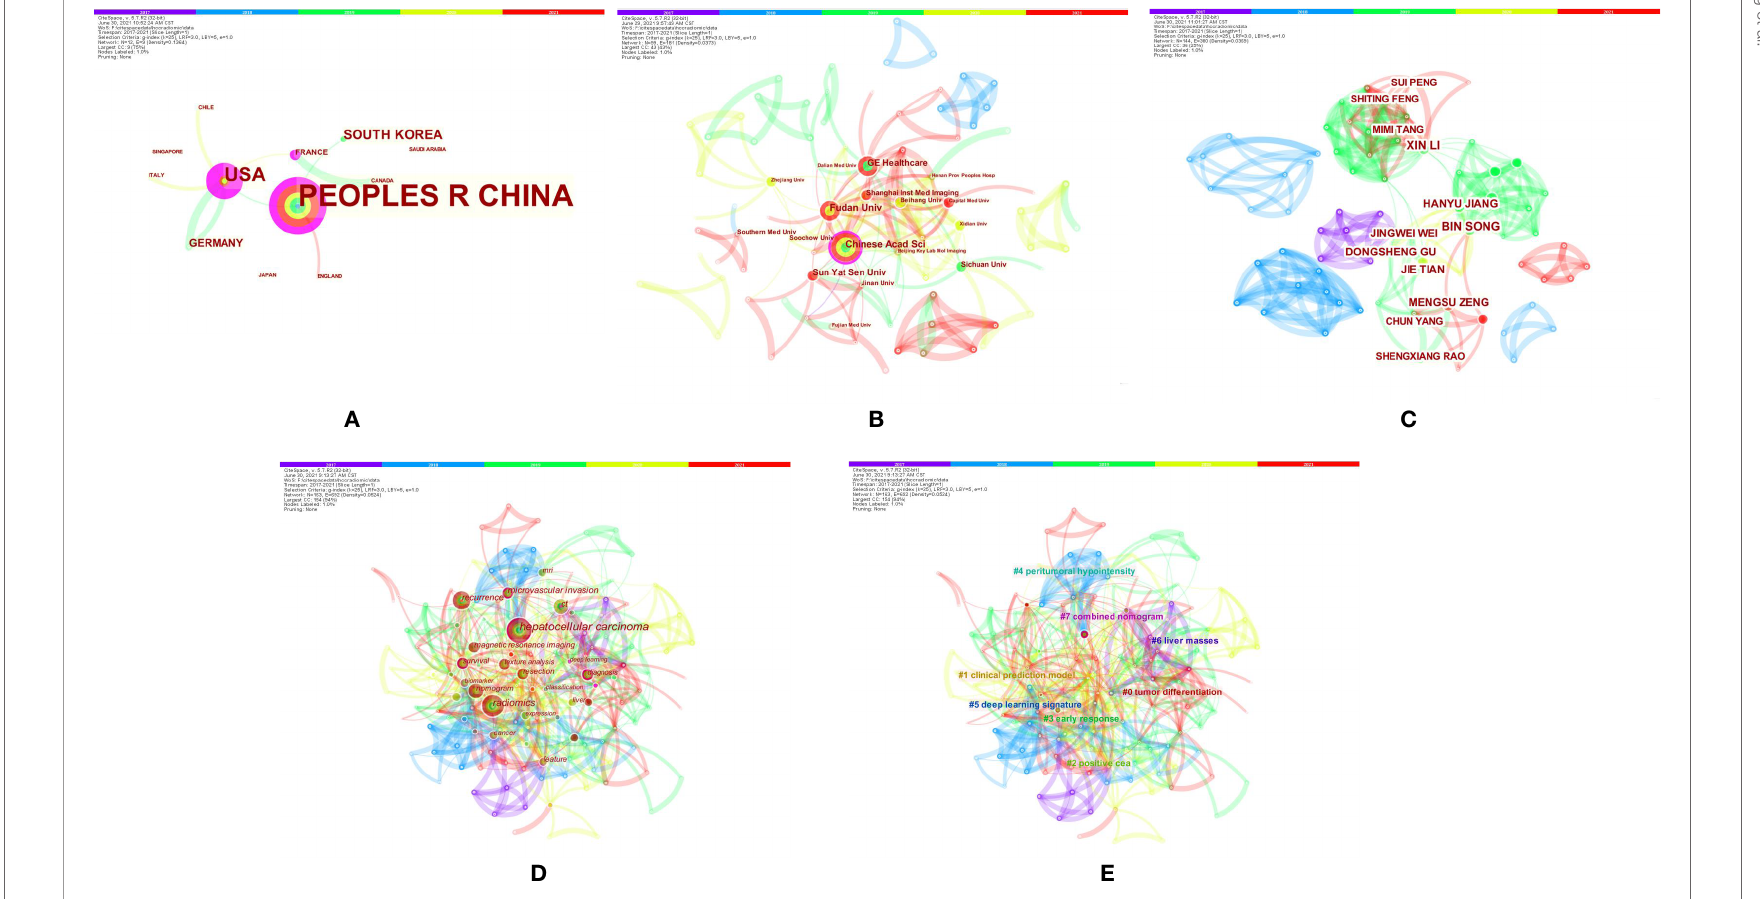
FIGURE 2 | Bibliometrics of magnetic resonance imaging radiomics in hepatocellular carcinoma. (A) Co-occurrence map of countries. (B) Co-occurrence map of institutions. (C) Co-occurrence map of authors. (D) Terms in theco-occurrence network. (E) Terms in theco-occurrence